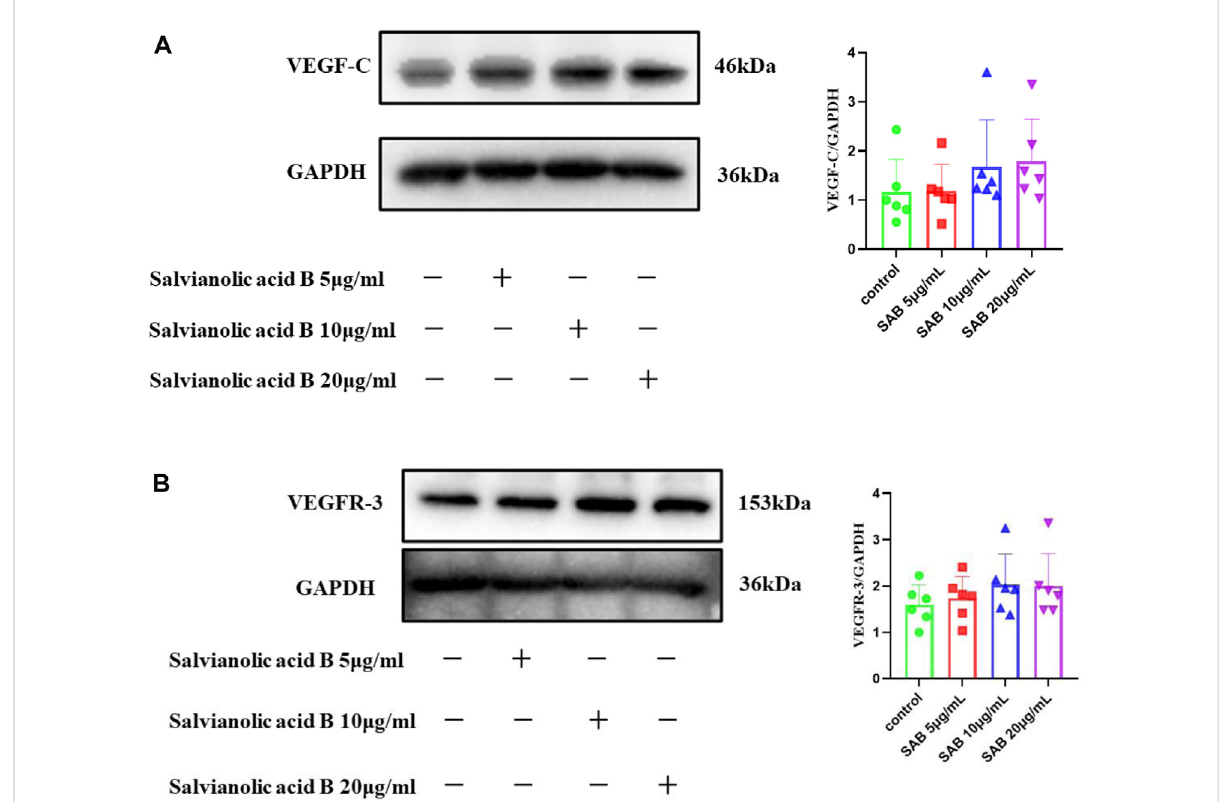
FIGURE 12 The protein expressions of VEGF-C and VEGFR-3. LECs were treated with different concentrations of SAB for 24h, and cell lysates were prepared and analyzed by western blot assay. (A) . Quantitation of the protein expression of VEGF-C. (B) . Quantitation of the protein expression of VEGFR-3